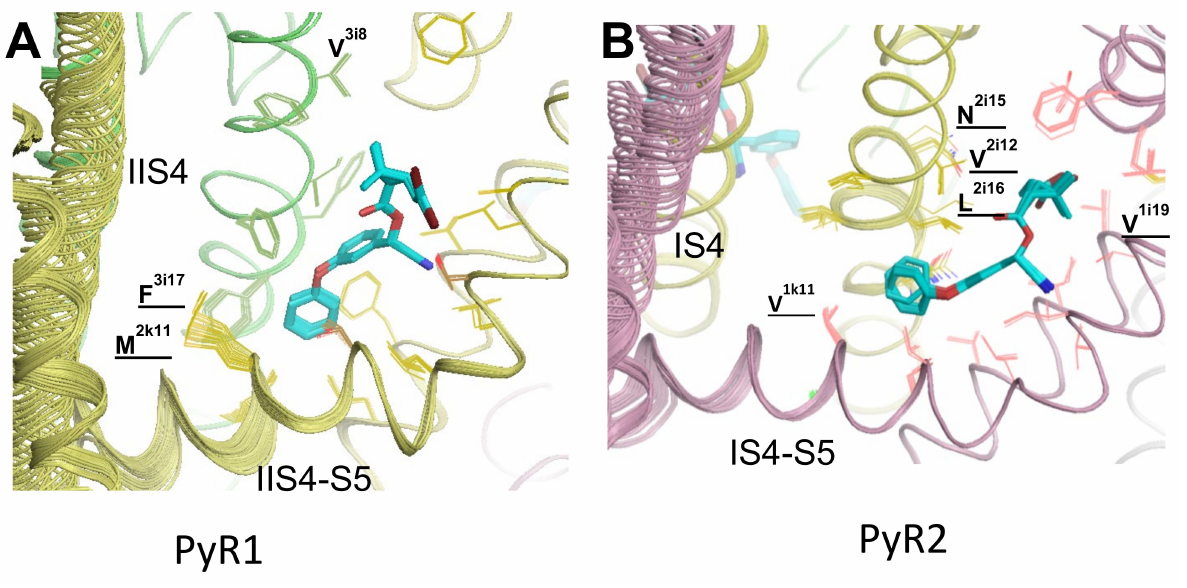
Figure 4. In-silico deactivating VSMs in DMT-bound model o AaNav1-1. ( A ) In site PyR1, the side chain of M 2k11 moves significantly from DMT. ( B ) In site PyR2, the side chains of I 2i13 and L 2i16 move from